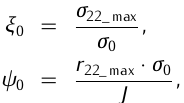
Figure 3. The influence of the number of the FE between the crack tip and the opening stress maximum location σ θ = 0 ◦ direction, on normalized location of the opening stress maximum (based on [11, 14, 16])